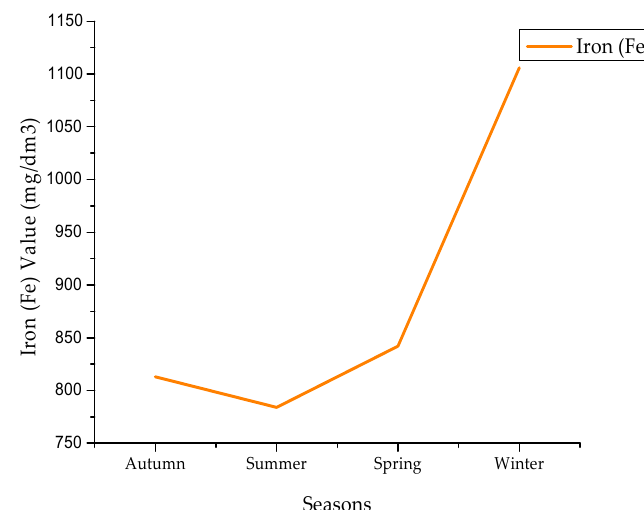
Figure 9. Concentration values for (Fe) from images during four seasons of 2017.